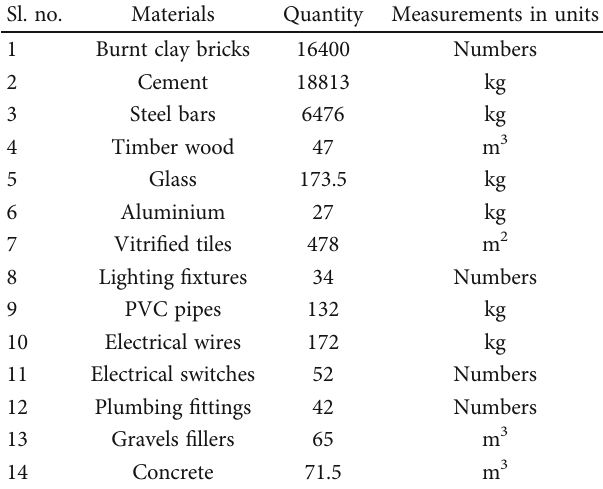
Table 2: Materials with the quantity used in residential building. Sl.